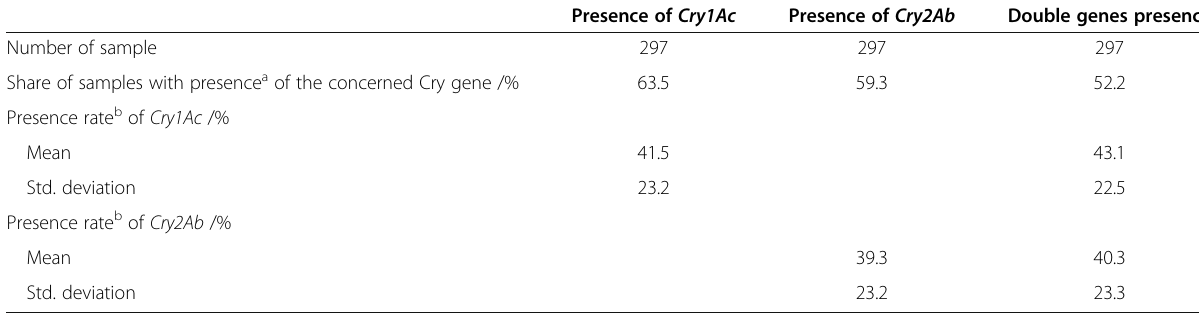
Table 1 Presence of Bt genes in seeds from fields cultivated with conventional variety Presence of Cry1Ac Presence of Cry2Ab Double genes presence Number of sample 297 297 297 Share of samples with presence a of the concerned Cry gene /%